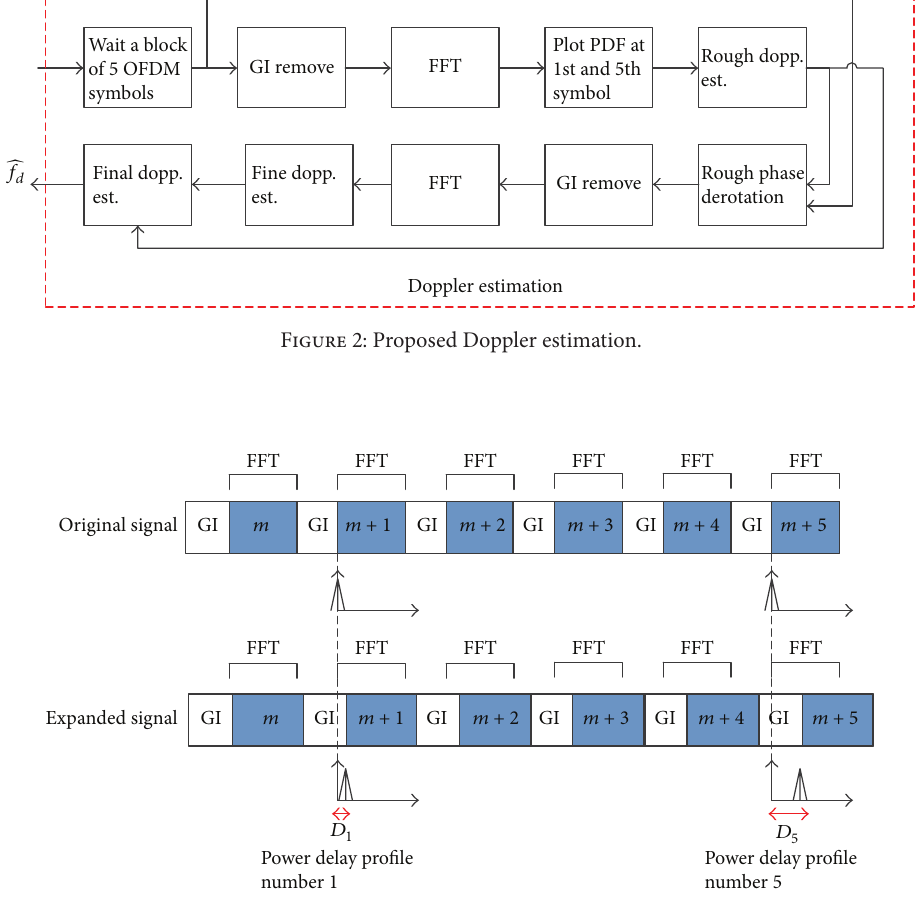
Figure 3: Rough Doppler estimation by monitoring the drift of